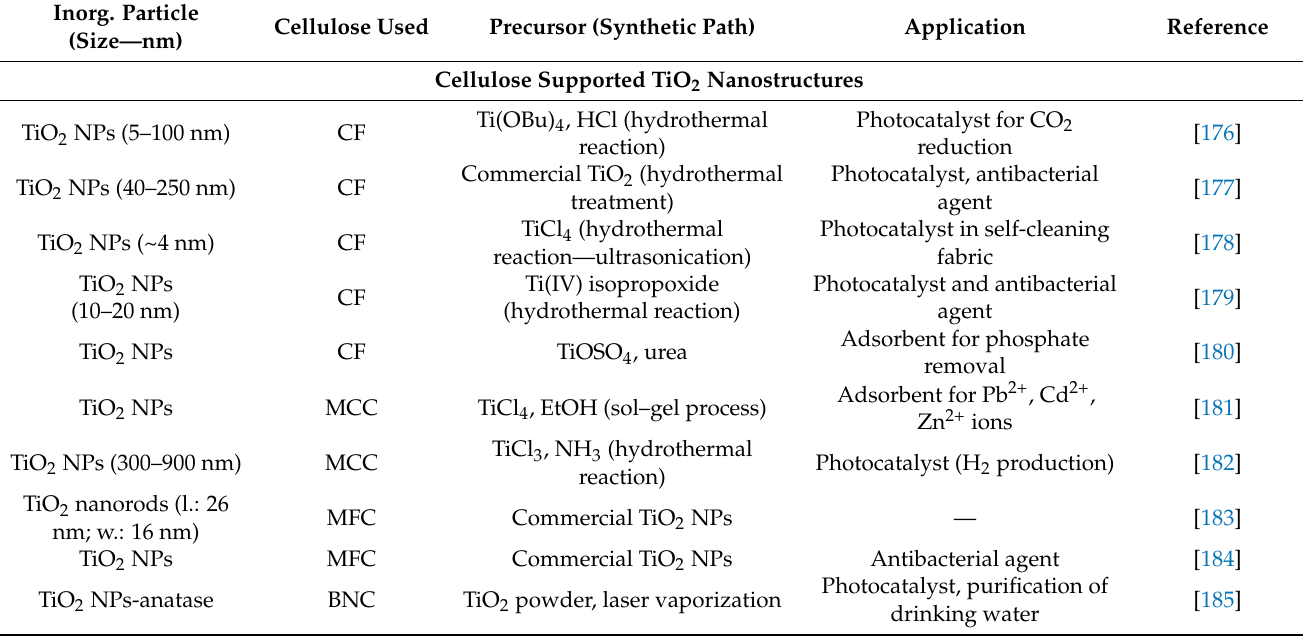
Table 3. The list of publications on the cellulose supported metal oxide nanostructures. The list is organized from large cellulose structures (CF and RC) via microstructured celluloses (MCC and MFC) to nanostructured celluloses (BNC and